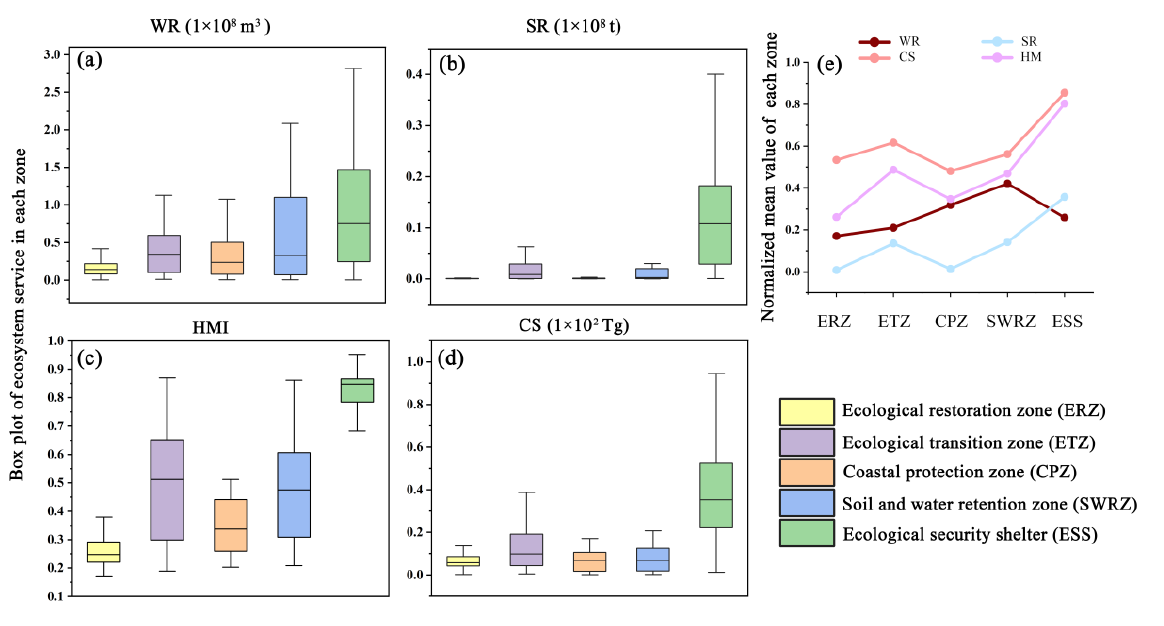
Figure 6. Statistics of ecosystem services in different ecological zones ( a – d ) and comparison of the normalized mean value of each zone ( e ).